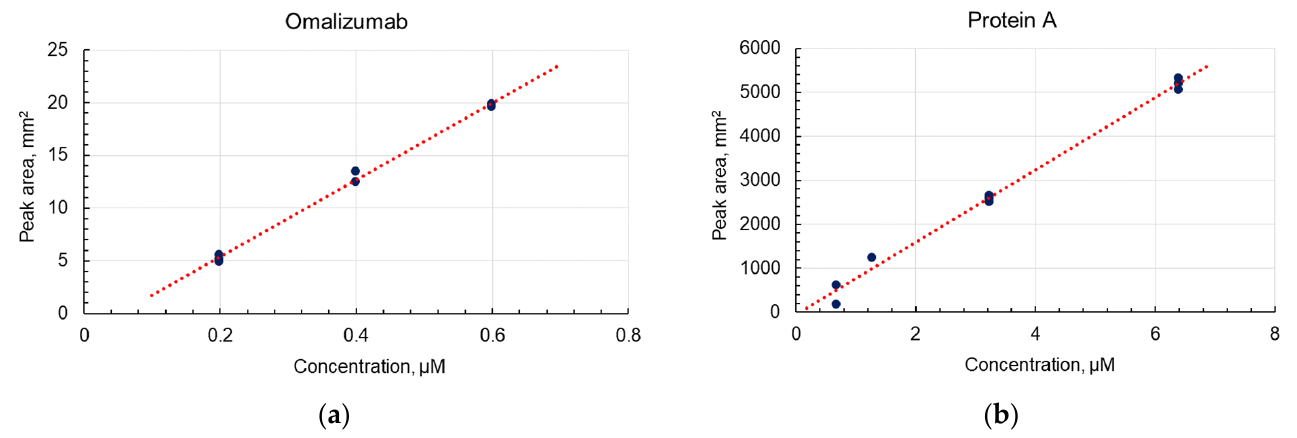
Figure 8. Concentration (µM) dependence of the electrophoretic peak area (mm 2 ): ( a ) omalizumab, y = 36.434x − 1.9043 (R 2 = 0.9982); ( b ) protein A, y = 821.88x − 53.334 (R 2 = 0.9974).